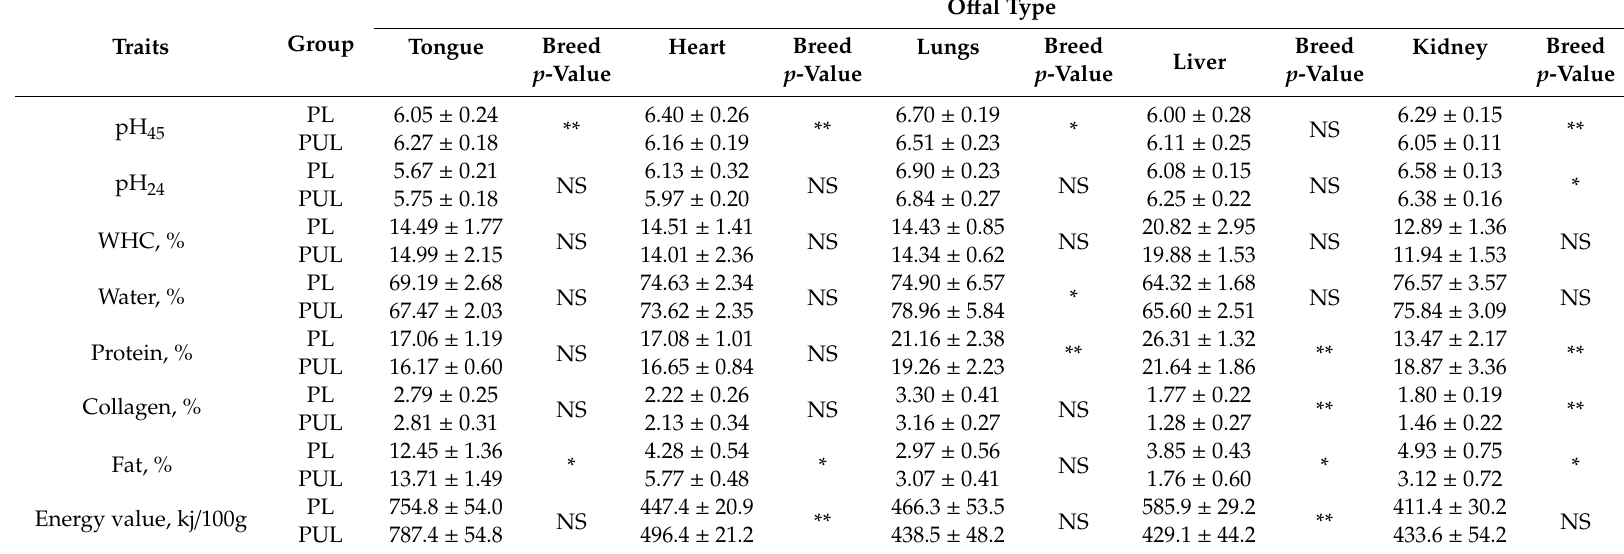
Table 3. Physical and chemical parameters of the evaluated o ff al depending on pig breed (mean ±